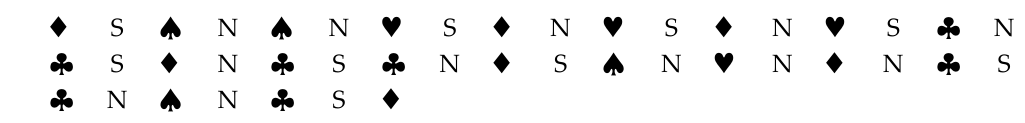
Figure 12. Extraction of mimicked information “COMMUNICATION” from the received signal.